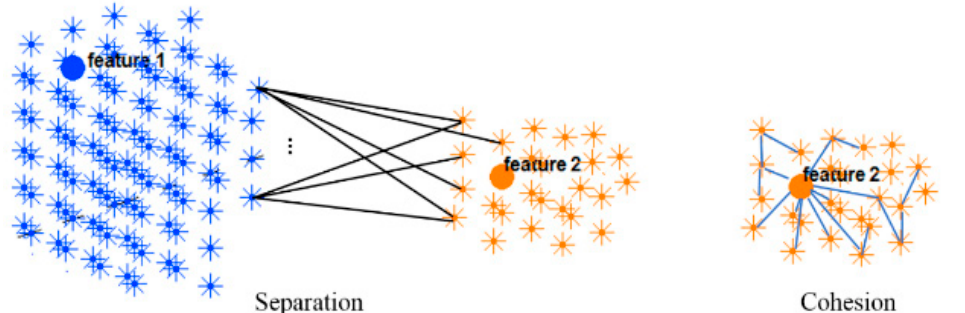
Figure 4. Two clusters of neurons in an SNN model were generated, each of which was associated with one EEG variable acting as a cluster center (input feature allocated to an input neuron). Cohesion measures how related the neurons are in a cluster through averaging the connection weights in the cluster, while separation measures how distinct a cluster is from other clusters through averaging the connection weights between the clusters.